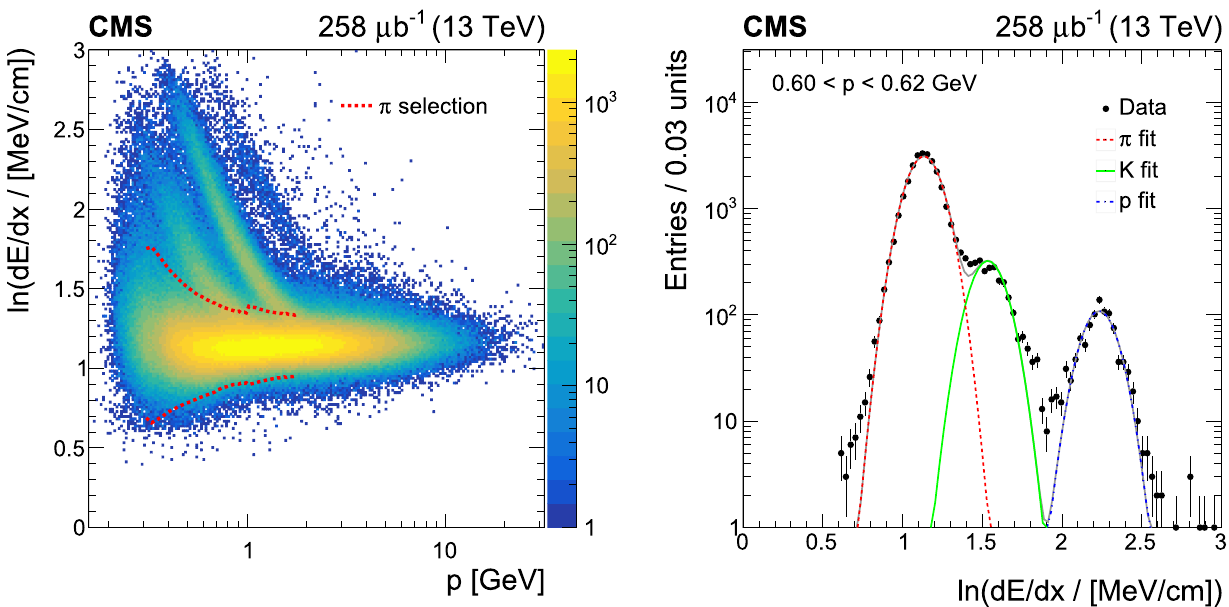
Fig. 2 Left: The distribution of the logarithm of the mean energy loss are identified as pions. Right: The fit of energy loss distributions in a and absolute value of the momentum of tracks from low-multiplicity given momentum bin with the sum of three Gaussian curves. Plots are √ s = 13TeV. The π -selection region is ( N track ≤ 4) events collected at similar for the 5.02TeV shown in the 0.3–2GeV range. All tracks outside this momentum range